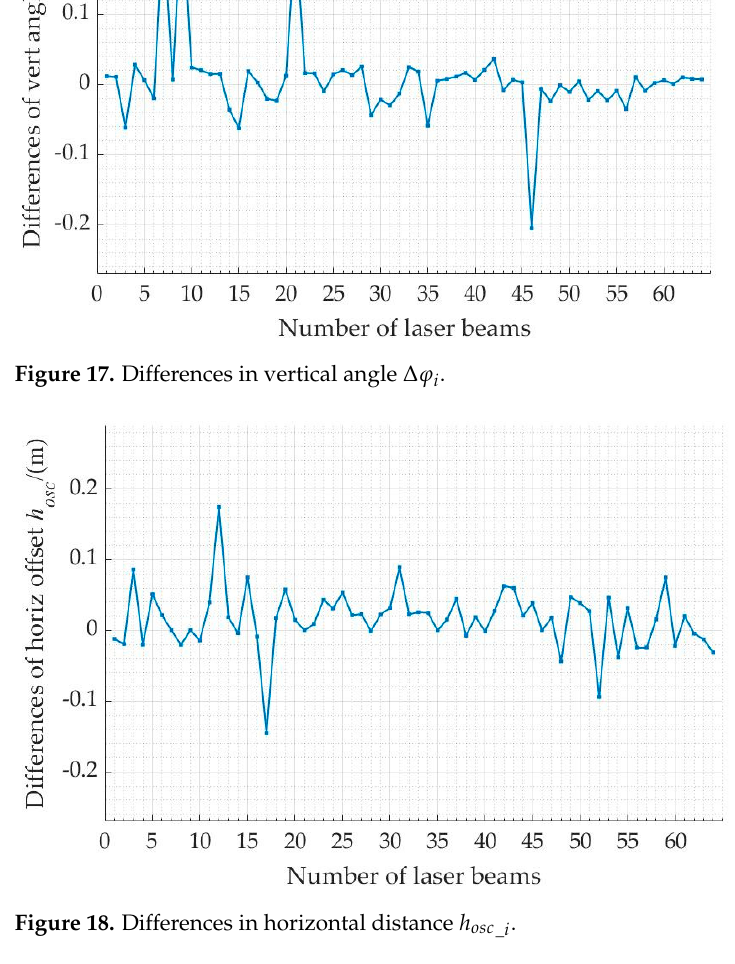
Figure 18. Differences in horizontal distance